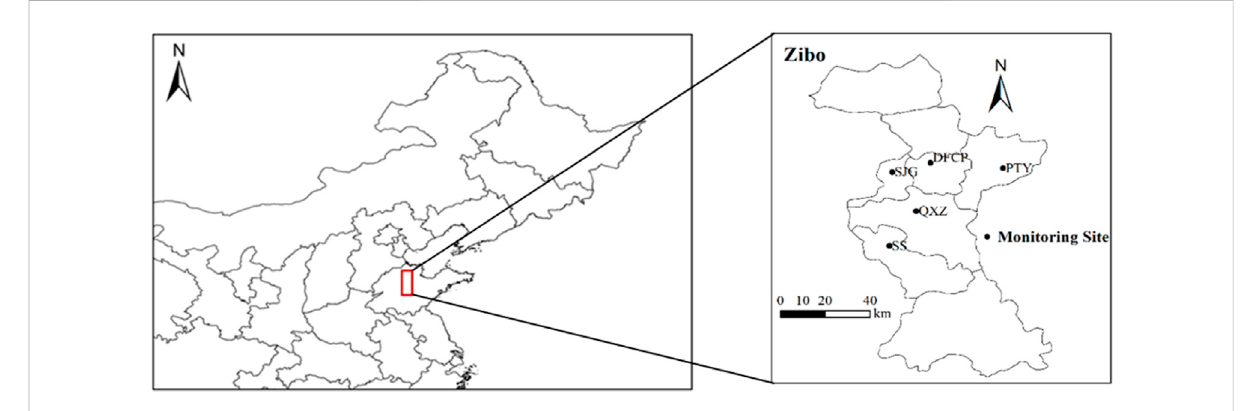
FIGURE 1 Location of the study area and air quality monitoring sites in Zibo